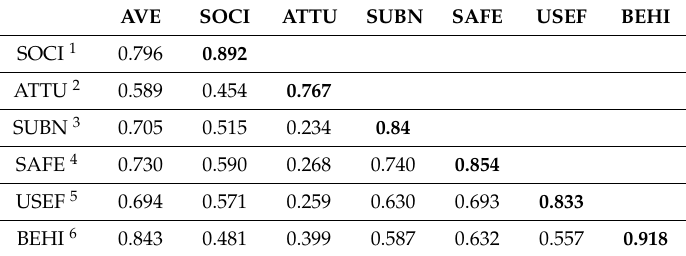
Table 5. The result of discriminant validity analysis.